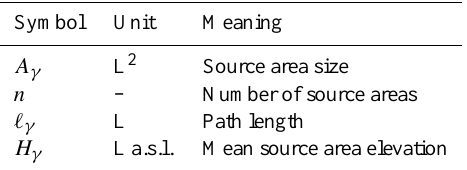
Table 1. Model parameters describing the physiographic catchment characteristics. The units are given in generic terms (L: